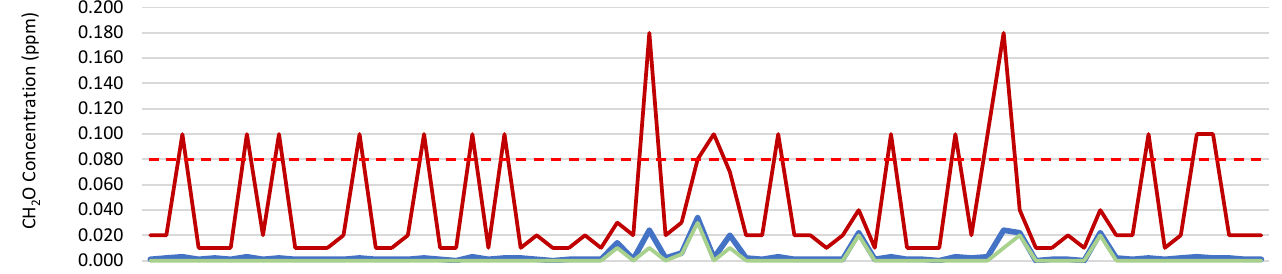
Figure 2. CO 2 concentration (ppm) outdoors.